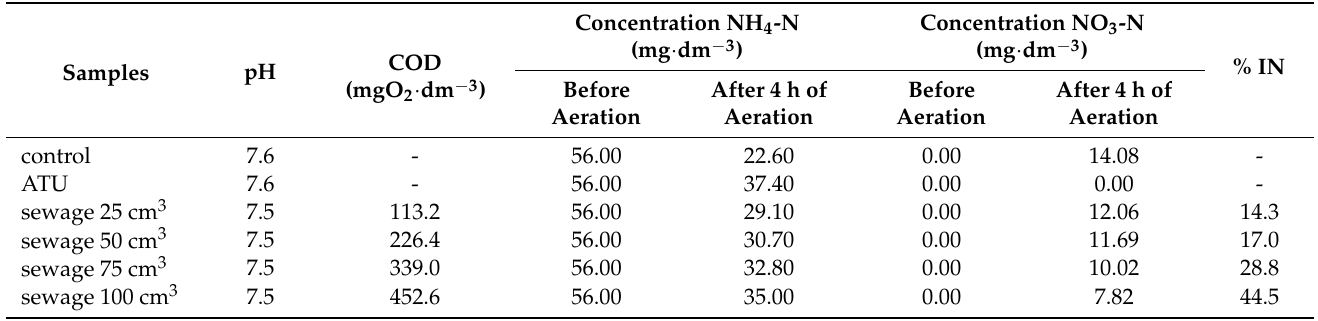
Table 6. Influence of COD of industrial wastewater from emulsifiers production on the nitrification inhibition in activated sludge under laboratory conditions.